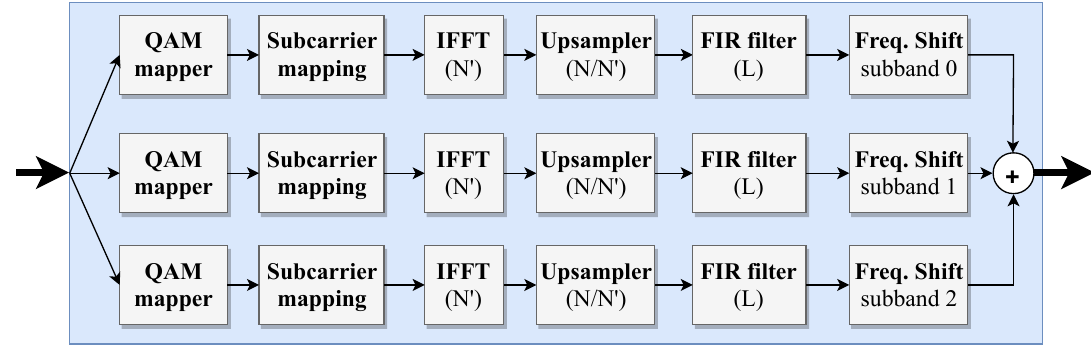
Figure 3. Datapath structure for UFMC baseband